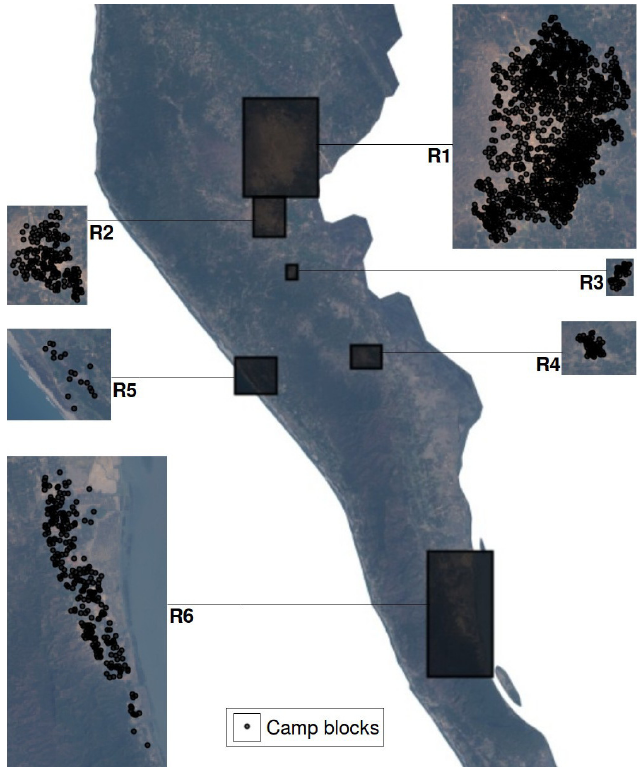
Fig. 2. Regions of study area and corresponding camp blocks.